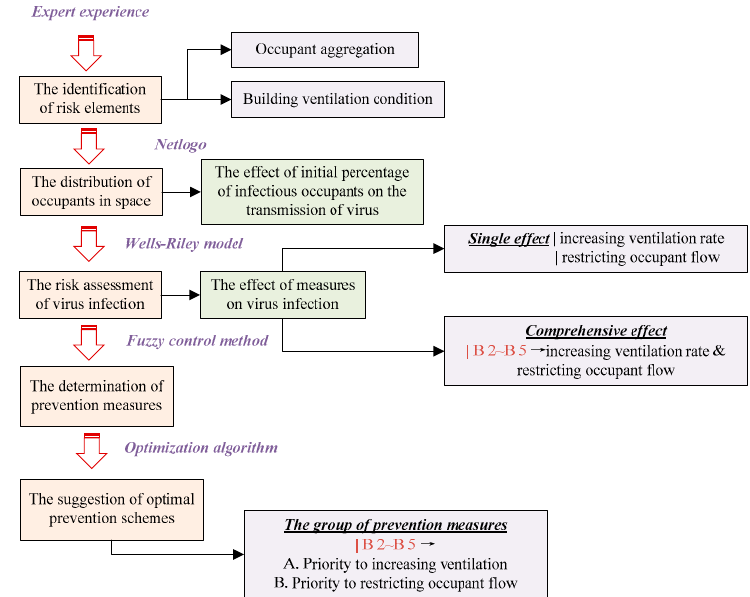
Figure 1. Research framework for risk assessment and suggestion.